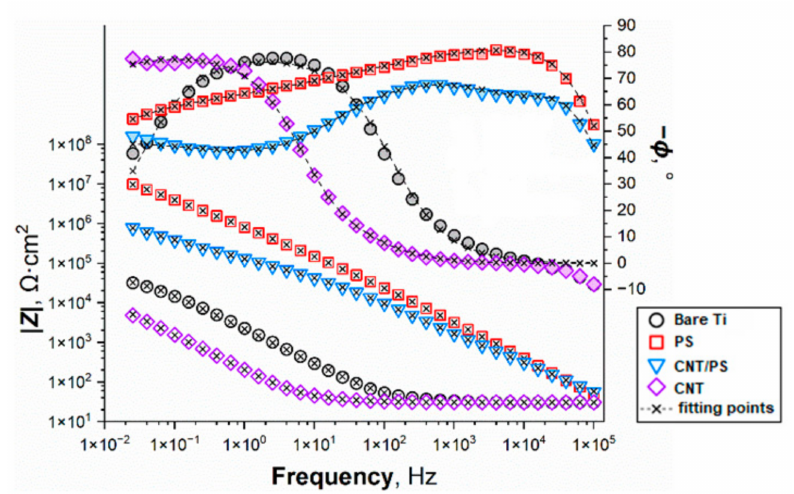
Figure 6. EIS spectra of titanium samples coated with PS, CNT and co-deposited CNT/PS recorded in Ringer’s solution after 2 h of immersion presented as magnitude (left axis) and phase (right axis) Bode plots. Empty symbols correspond to the impedance magnitude data, whereas the phase angle points are depicted as the shaded symbols. Table 2. EIS fitting parameters used in the analysis of the impedance spectra of the titanium samples. Bare